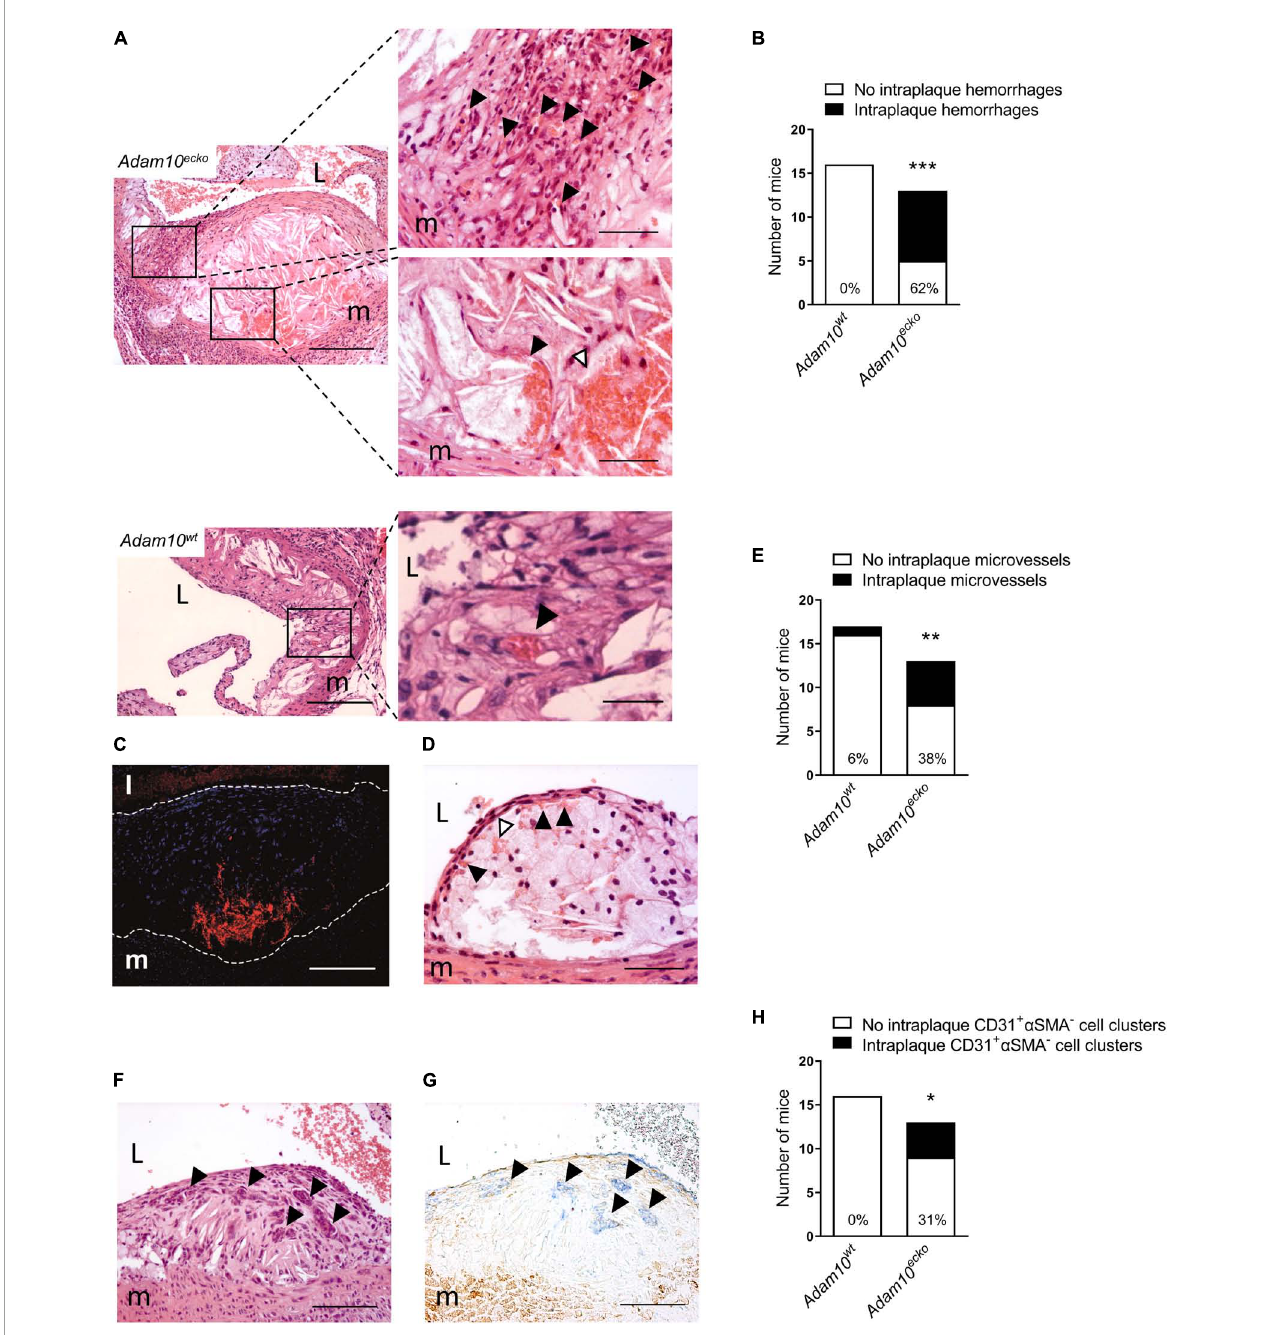
FIGURE3 Atherosclerotic lesions of Adam10 ecko mice display several plaque destabilizing features. (A) Adam10 ecko left panel: Atherosclerotic lesion in the aortic root containing pronounced intraplaque hemorrhage and microvessels of an Adam10 ecko mouse (H&E, scale bar, 400 µ m). Adam10 ecko upper right detail panel: Detail of multiple small microvessels containing erythrocytes (indicated with black arrowheads) in aortic root lesion (H&E, scale bar, 200 µ m). Adam10 ecko lower right detail panel: Detail of a large microvessel containing erythrocytes (indicated with black arrowhead) and intraplaque hemorrhage (indicated with white arrowhead) at the plaque base in the aortic root (H&E, scale bar, 50 µ m). Adam10 wt left panel: Atherosclerotic lesion in the aortic root of an Adam10 wt mouse containing a microvessel (H&E, scale bar, 400 µ m). Adam10 wt right detail panel: Detail of the microvessel containing erythrocytes (indicated with black arrowhead) in aortic root lesion (H&E, scale bar, 50 µ m). (B) Quantification of intraplaque hemorrhage in aortic root of Adam10 wt and Adam10 ecko mice after 12 weeks on western type diet. (C) Immunofluorescence staining of erythrocytes (TER-119, red) in the atherosclerotic intima (cell nuclei, DAPI, blue) of an adjacent slide shown in panel ( A ; scale bar, 100 µ m). Lesion borders are indicated with dashed lines. (D) Atherosclerotic lesions containing intraplaque hemorrhage (indicated with white arrowheads) possibly originating from neovessels from the luminal side of the aorta (indicated with black arrowheads; H&E, scale bar, 100 µ m). (E) Quantification of intraplaque microvessels in aortic root of Adam10 wt and Adam10 ecko mice after 12 weeks on western type diet. (F,G) Clusters of cells (indicated with black arrowheads) within an atherosclerotic lesion of an Adam10 ecko mouse ( F , H&E, scale bar, 100 µ m), which are positive for CD31 ( G , blue, indicated by black arrowheads) and negative for α -SMA (G, brown; scale bar, 100 µ m). (H) Quantification of intraplaque CD31 + α SMA - cell clusters in aortic root of Adam10 wt and Adam10 ecko mice